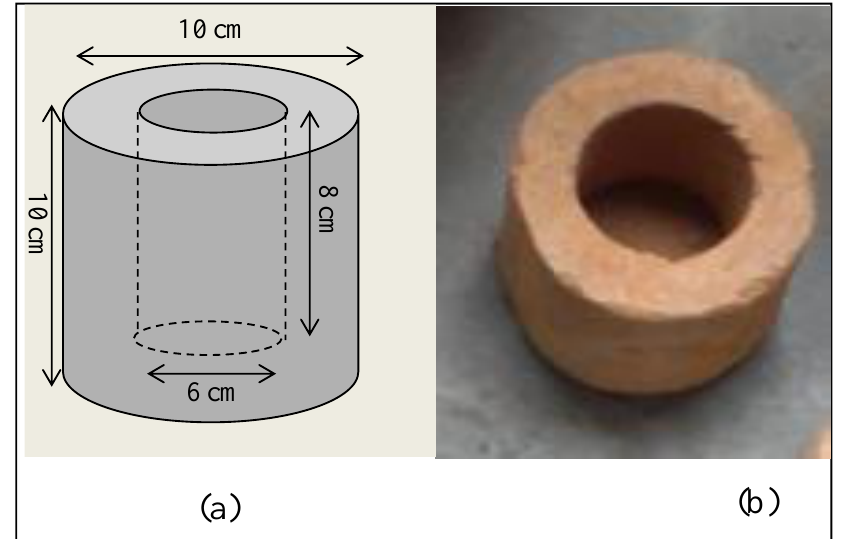
Figure 1. ( a )Schematic presentation of ceramic filter. ( b ) Ceramic filter after burning. Figure 1. ( a ) Schematic presentation of ceramic filter; ( b ) Ceramic filter after